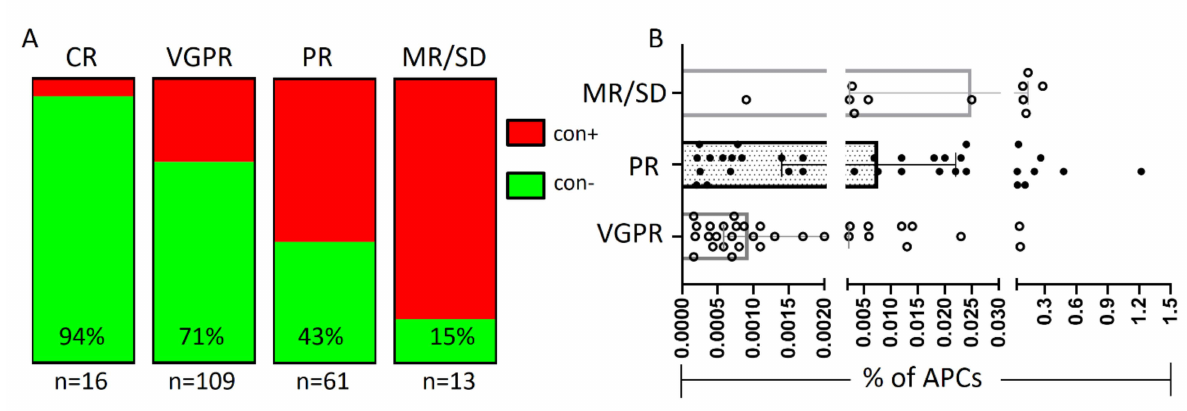
Figure 2. The presence of graft contamination according to the depth of response post induction treatment. Frequency of graft contamination in the various response categories ( A ) and distribution of residual myeloma burden in autologous grafts on the distinct response groups ( B ). con+, contaminated graft samples; con − , uncontaminated graft samples; CR, complete response; MR/SD, minor response/stable disease; n, number of cases in each group; PR, partial response; VGPR, very good partial response.